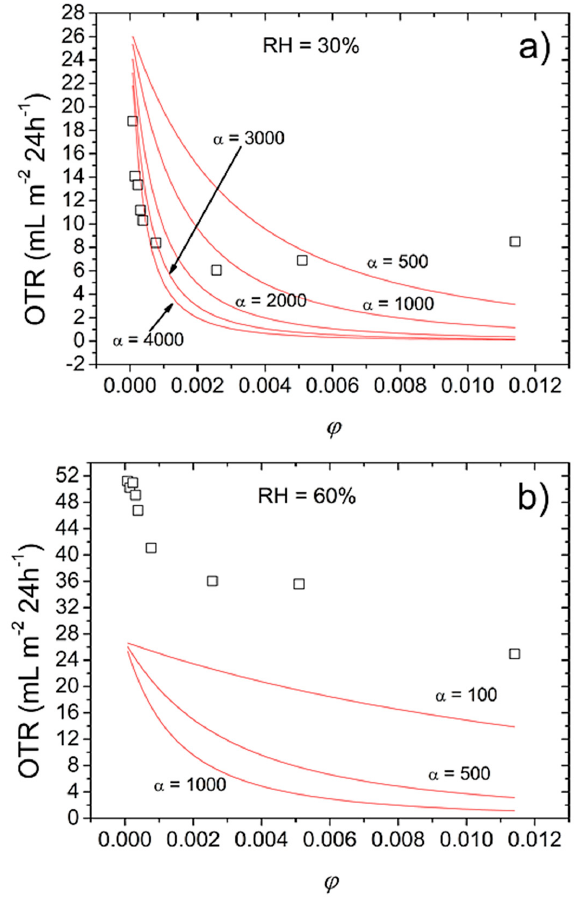
Figure 2. Experimental (symbols) and predicted (solid lines) OTR values of bionanocomposite hybrid coatings as a function of filler volume fraction ( ϕ ) for different aspect ratio ( α ) of mica platelets at ( a ) 30% RH and ( b ) 60% RH, according to Cussler’s model (Equation (1) in the text). Above the 0.2 wt % ( ϕ = 0.00077) threshold, a clear deviation was observed between